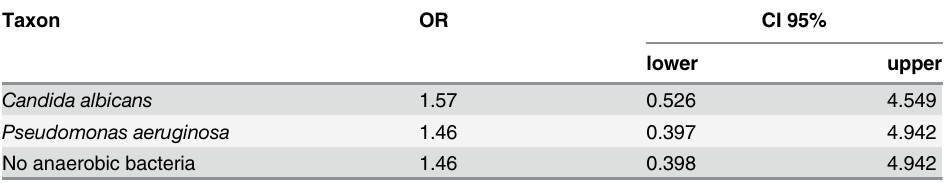
Table 3. Odds ratio from culturable microflora with differential occurrence in FEV 1 groups. Taxon OR CI 95% lower upper Candida albicans 1.57 0.526 4.549 Pseudomonas aeruginosa 1.46 0.397 4.942 No anaerobic bacteria 1.46 0.398 4.942 Data report the taxa detected from Principal Component Analysis (Fig 1), the odds ratio (OR) of association between FEV 1 values in the FEV 1 group III with respect to a cohort composed by FEV 1 group I and FEV 1 group II patients, the 95% con fi dence intervals (CI 95%). Statistically signi fi cant ORs are reported in bold. FEV 1 , group I = normal/mild (FEV 1 % > 70); FEV 1 , group II = moderate (70 (cid:1) FEV 1 % (cid:1) 40); FEV 1 , group III = severe (FEV 1 % <